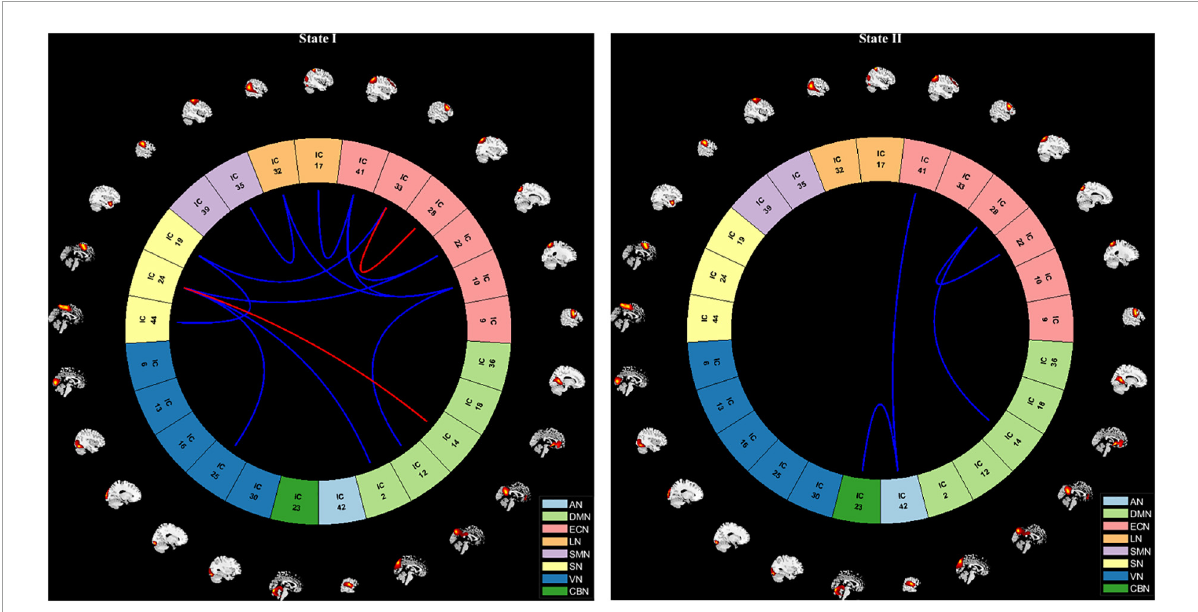
FIGURE6 Visualization of functional network connectivity differences in two states ( p < 0.01, FDR correction). The red line represents increased functional connectivity and the blue line represents decreased functional connectivity in OSA patients. AN, auditory network; DMN, default mode network; ECN, executive control network; LN, language network; SMN, sensorimotor network; SN, salience network; VN, visual network; CBN, cerebellar network.